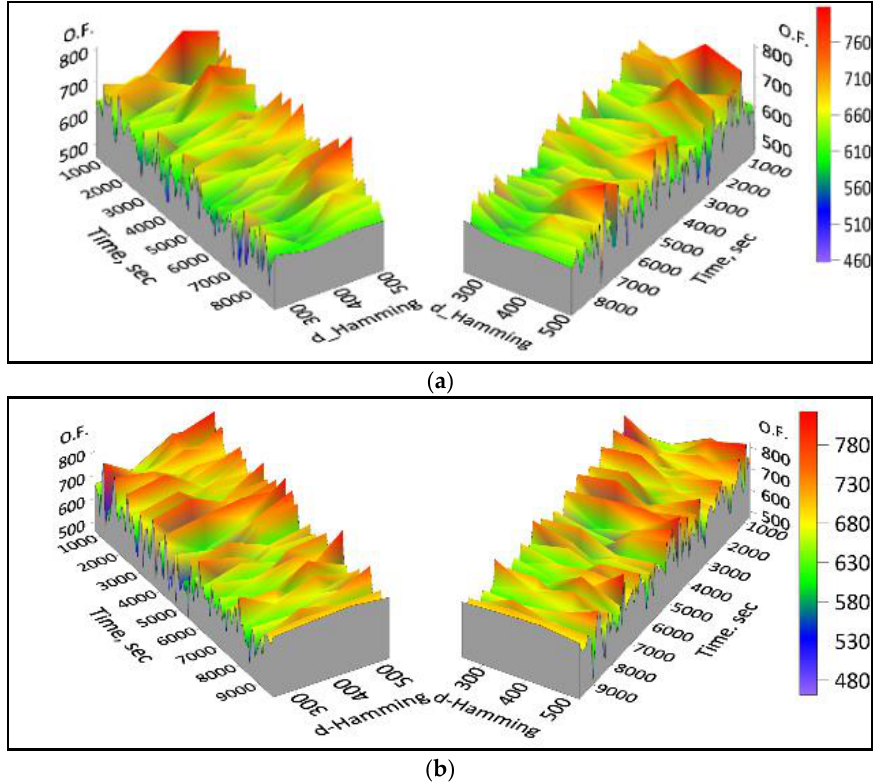
Figure 5. SACP with 48 processes generating the landscape without applying cooperation between the processes. Results of 30 tests. ( a ) Instance large01. ( b ) Instance